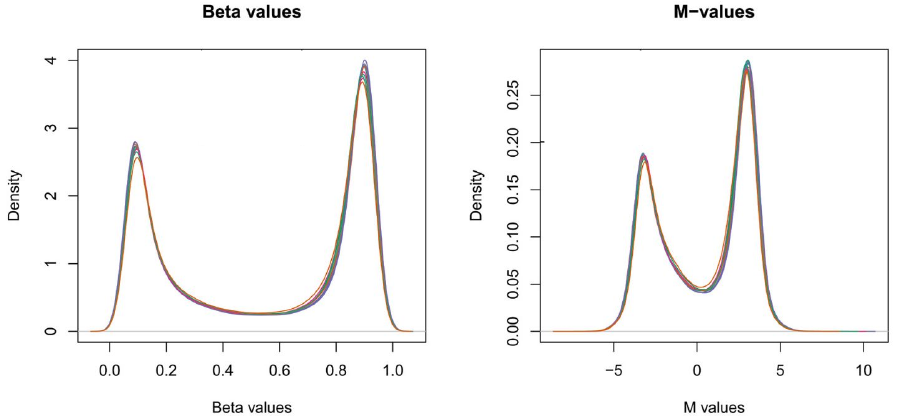
Figure 2. Comparison between β and M values. This image was taken and modified from